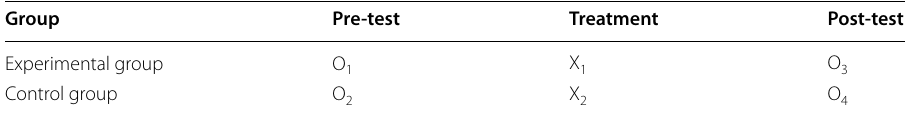
Table 1 Research design of this study Group Pre‑test Treatment Post‑test Experimental group O 1 O 3 Control group O O 1 and O 2 were the Web Design Skills Test; O 3 and O 4 were Web Design Skills Test and Knowledge Integration Scale; X 1 was the course designed with the DBL model; X 2 was a programming course